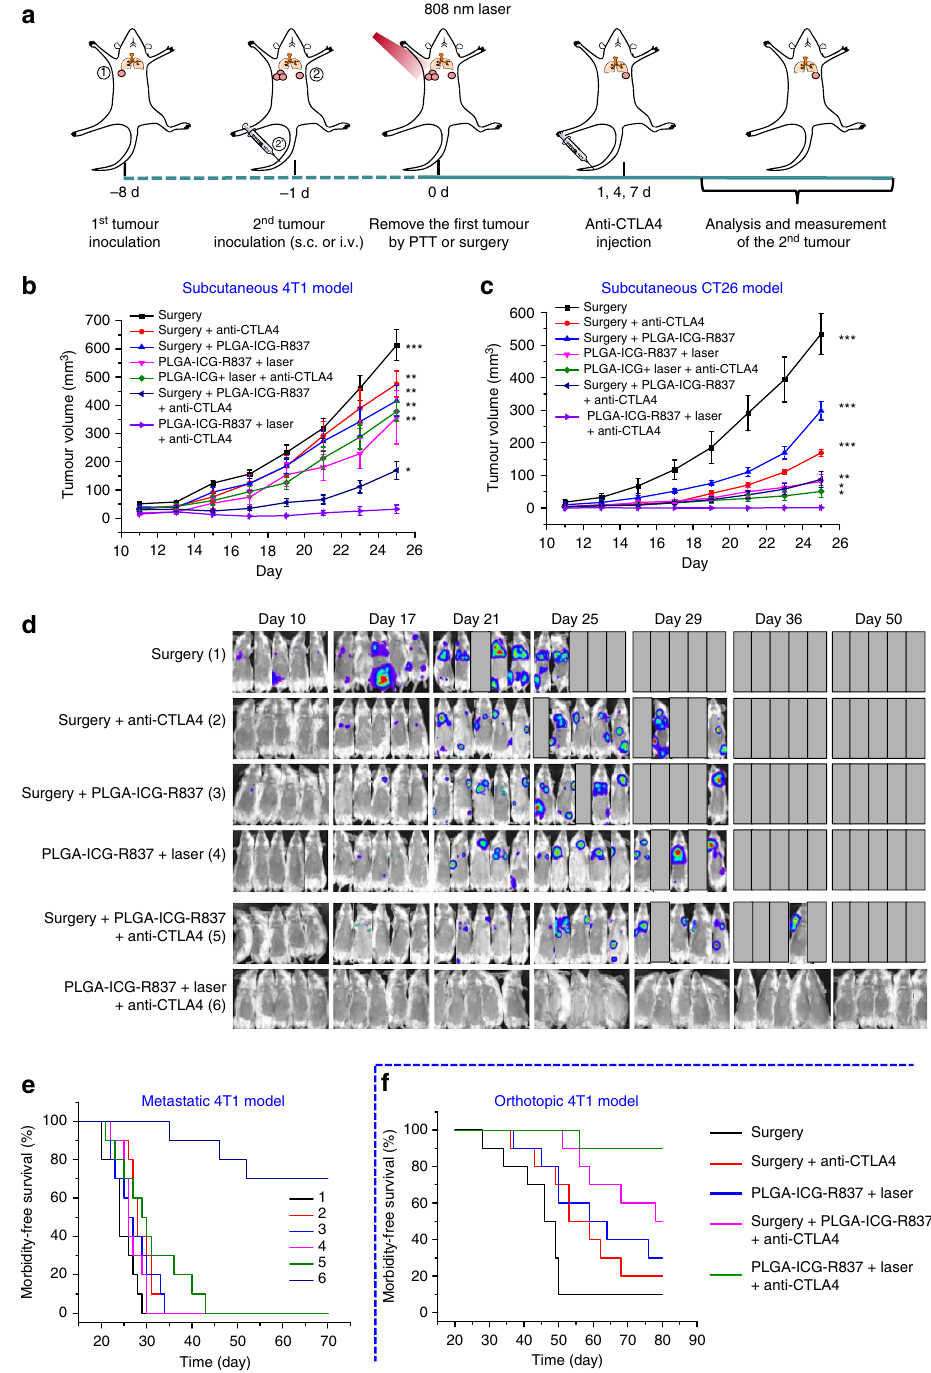
Figure 3 | Anti-tumour effect of PLGA-ICG-R837-based PTT plus anti-CTLA-4 therapy. ( a ) Schematic illustration of PLGA-ICG-R837-based PTT and anti-CTLA-4 combination therapy to inhibit tumour growth at distant sites. ( b , c ) Tumour growth curves of different groups of mice (six mice per group) with s.c. inoculation of secondary 4T1 ( b ) or CT26 ( c ) tumours after various treatments to eliminate their primary tumours. ( d ) In vivo bioluminescence images to track the spreading and growth of i.v. injected fLuc-4T1 cancer cells in different groups of mice after the cancer cells after various treatments to eliminate their primary tumours. ( e ) Morbidity-free survival of different groups of mice with metastatic 4T1 tumours in d after various treatments indicated to eliminate their primary tumours (10 mice per group). ( f ) Morbidity-free survival of different groups of mice-bearing orthotopic 4T1 tumours with spontaneous metastases after various treatments indicated to eliminate their primary breast tumours (10 mice per group). PLGA-ICG-R837- based photothermal ablation of the first primary tumours in combination with anti-CTLA4 treatment would be able to induce strong anti-tumour immunological effects to inhibit the growth of tumour cells spread into other organs. P values in b and c were calculated by Tukey’s post-hoc test (*** P o 0.001, ** P o 0.01 or * P o 0.05) by comparing other groups with the last group (PLGA-ICG-R837 þ laser þ anti-CLTA-4). Data are presented as the mean ±